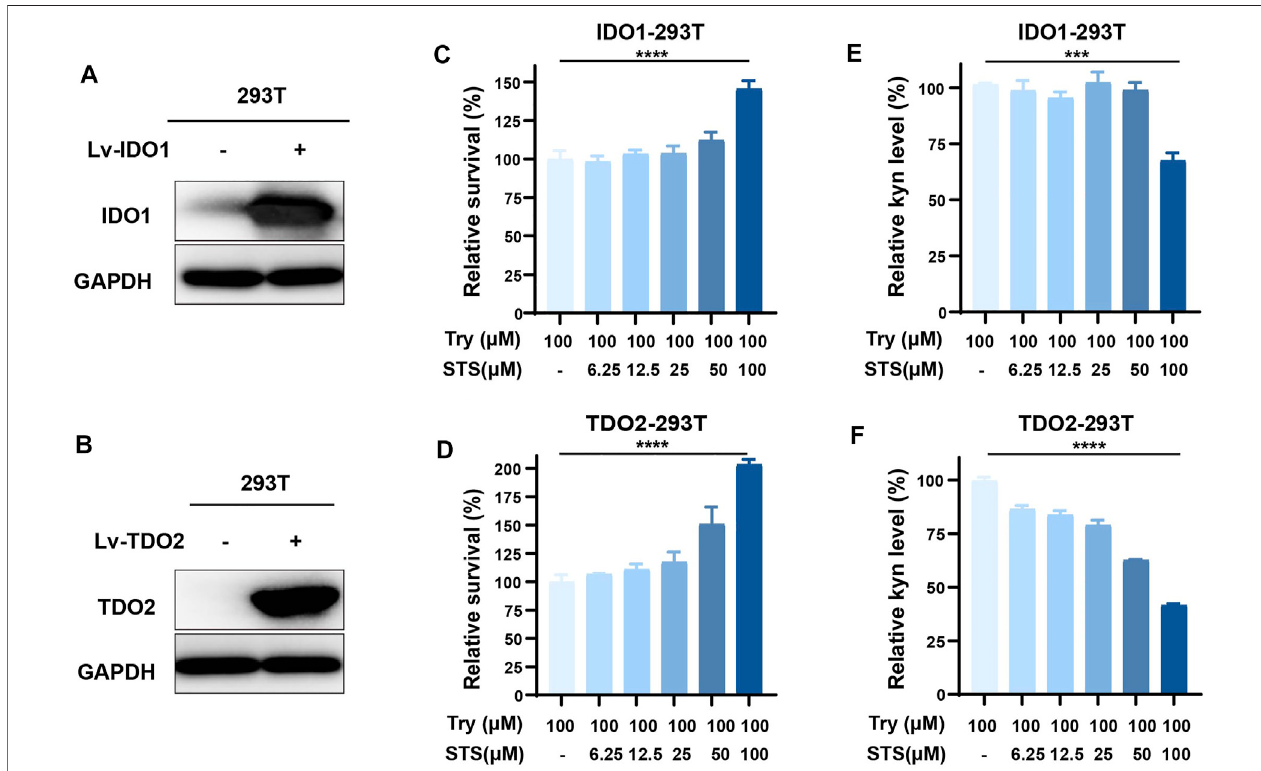
FIGURE 2 | STS suppressed IDO1 and TDO2 activities intracellularly. (A) Overexpression of IDO1 in 293T cells. Western blot analysis was used to investigate protein expression level after transfecting the overexpression lentivirus for 48 h. Lv-IDO1 was the overexpressing lentivirus. (B) Overexpression of TDO2 in 293T cells. Western blot analysis was used to investigate protein expression level after transfecting the overexpression lentivirus for 48 h. Lv-TDO2 was the overexpression lentivirus. (C,D) TheeffectofSTSontheproliferationofIDO1-293TandTDO2-293Tcells. (E) STSdecreasedtheproductionofkyninIDO1-293Tcells.Theeffectof STS on cell growth wasconsidered during dataanalysis. (F) STSdecreased theproduction ofkyn in TDO2-293T cells. The effect of STSon cell growth was considered during data analysis. After the kyn was detected in the medium, the cell proliferation was measured by MTT assays. Statistical data are represented as the mean ± SD. *** p < 0.001 and **** p < 0.0001 analyzed by